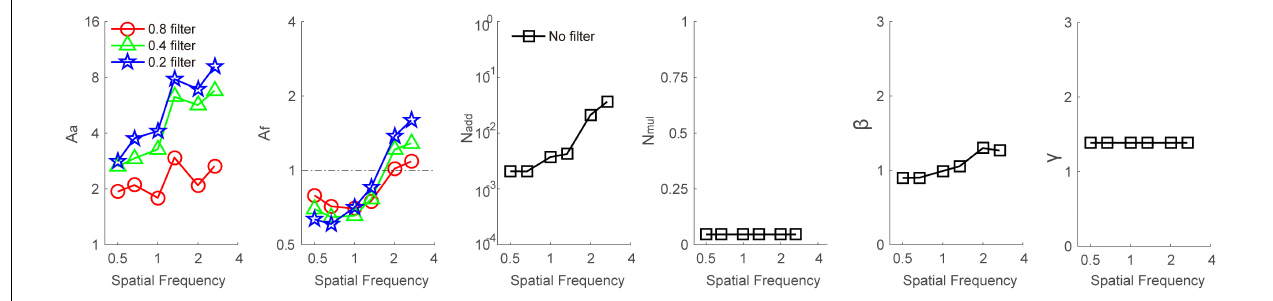
FIGURE 4 | A a , A f , N add , N mul , β , and γ as a function of spatial frequencies at baseline (dark square), 0.8 (red circle), 0.4 (green triangle), and 0.2 (blue pentagon) filter levels, respectively. Different viewing conditions shared N add , N mul , β , and γ